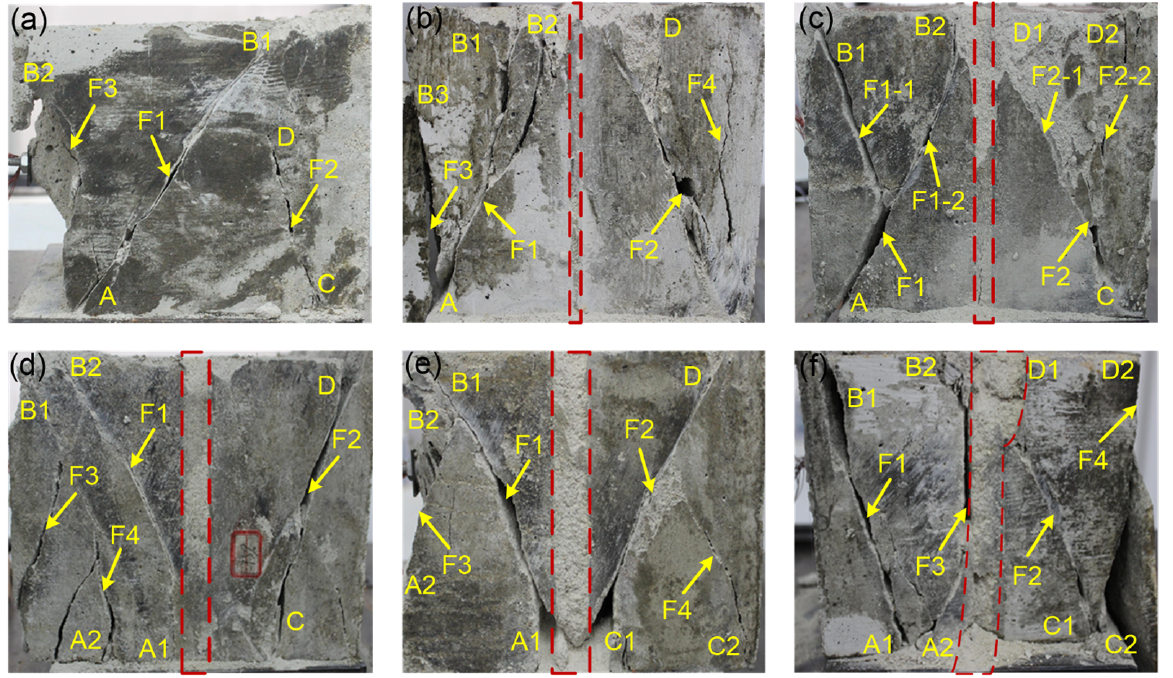
Figure 11. Failure characteristics of samples containing weak interlayers with different thicknesses: ( a ) t w = 0 mm; ( b ) t w = 5 mm; ( c ) t w = 10 mm; ( d ) t w = 15 mm; ( e ) t w = 20 mm; ( f ) t w = 25 mm.